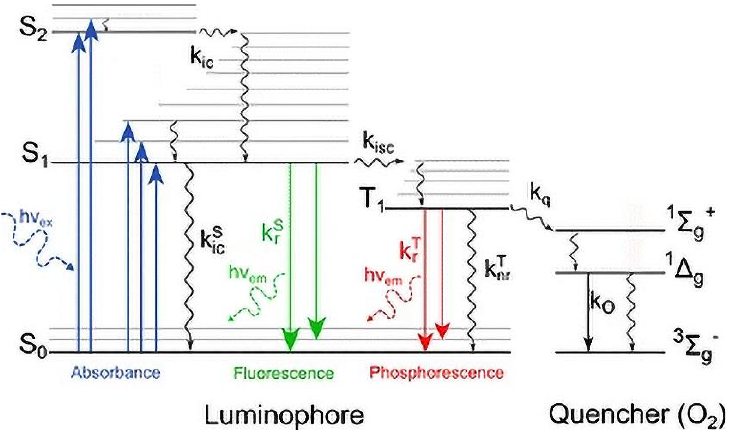
Figure 2. Semiconductor band diagram with charge transitions. (Reprinted from [23]; with the permission of the author).